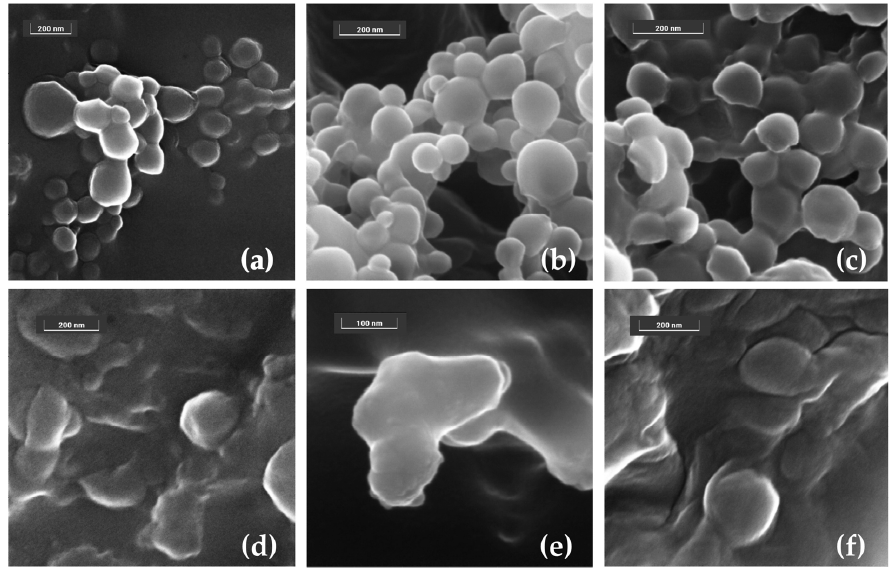
Figure 7. FESEM representative images of HA 4.8 -DPPE/PLGA 75:25 nanoparticles ( a – c ) and HA 4.8 - DPPE-liposomes ( d – f ) in their as prepared form ( a , d ), after freeze drying ( b , e ) and after